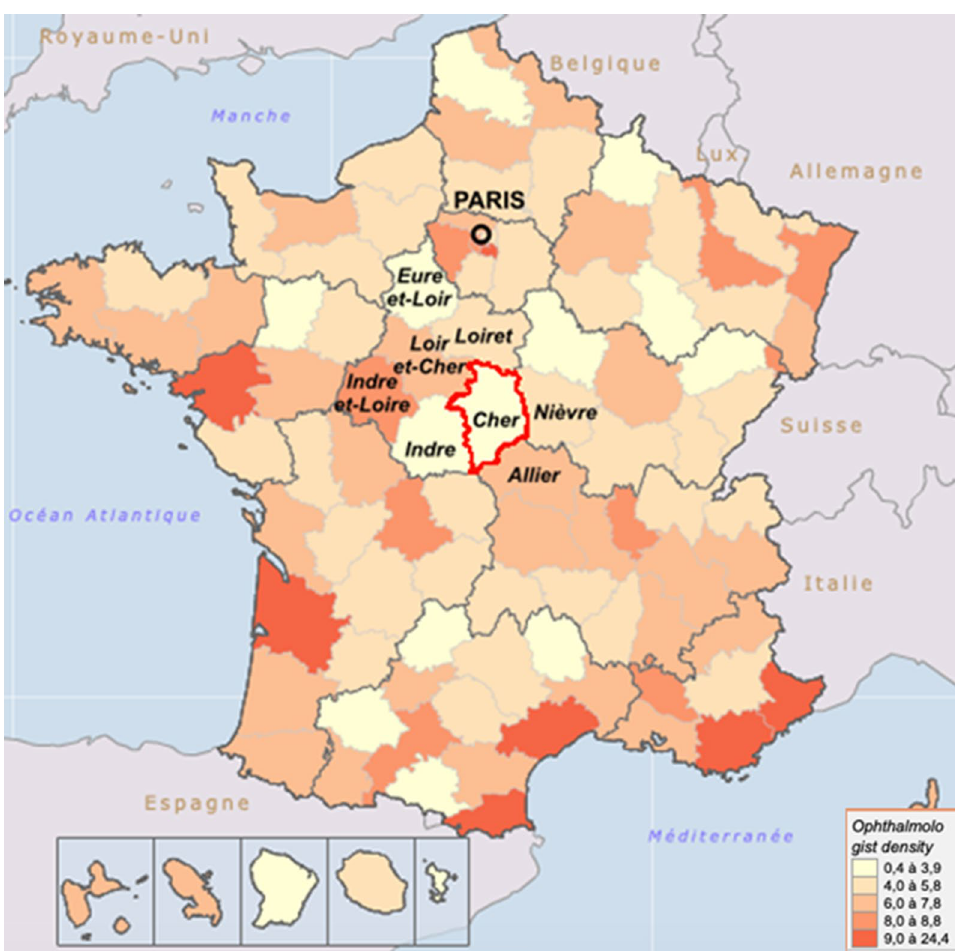
Figure 1. Cartography of ophthalmologist density (according to area) expressed per 100,000 inhabitants (extracted from https:// demog raphie. medec in. fr/ mobile. php by